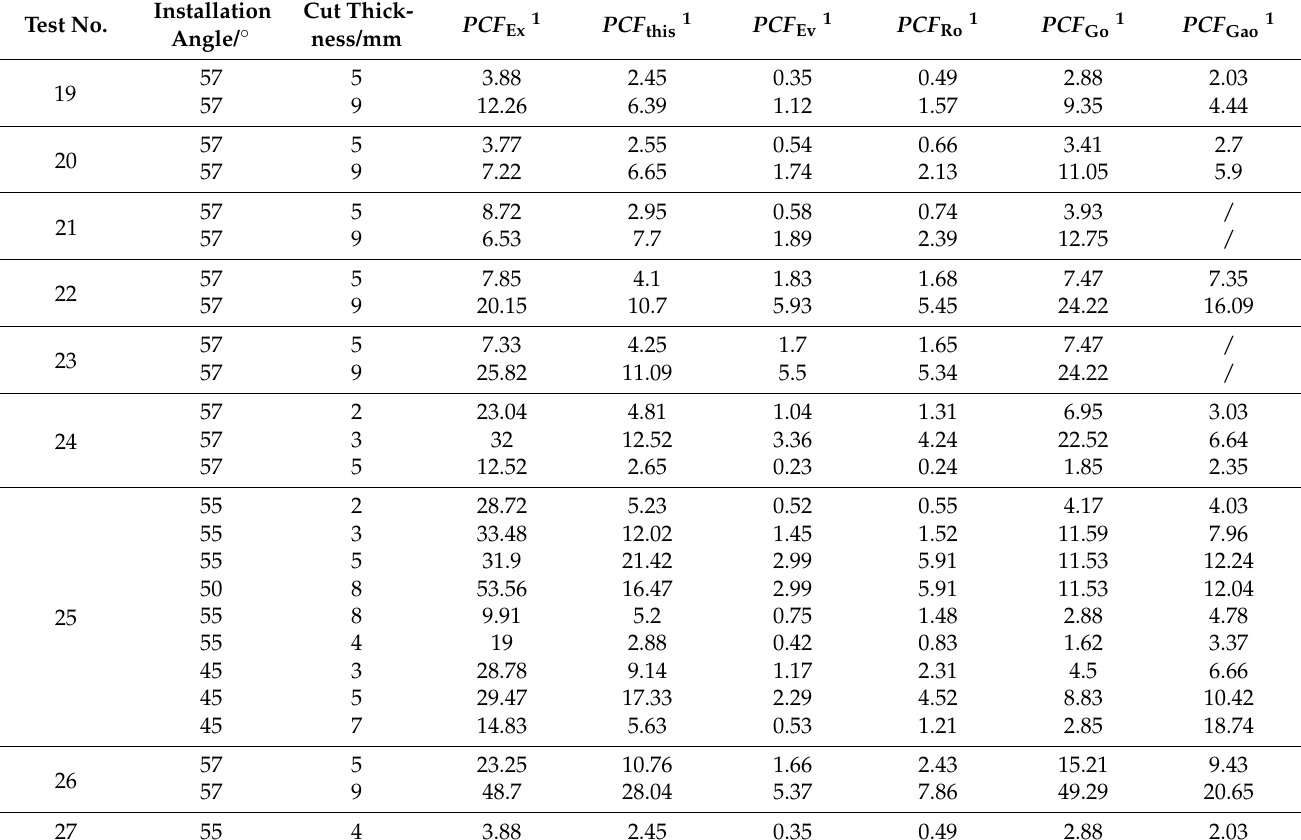
Table 7. The added value of PCF obtained by full-scale rock cutting experiments and theoretical models for the third prediction performance